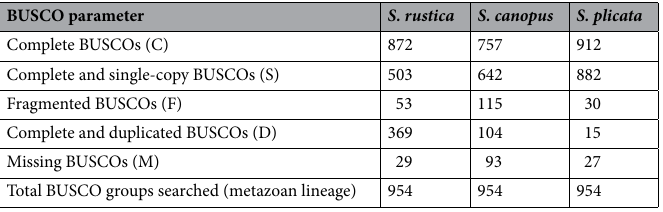
Table 3. BUSCO evaluation of S. rustica transcriptome compared to other Styela